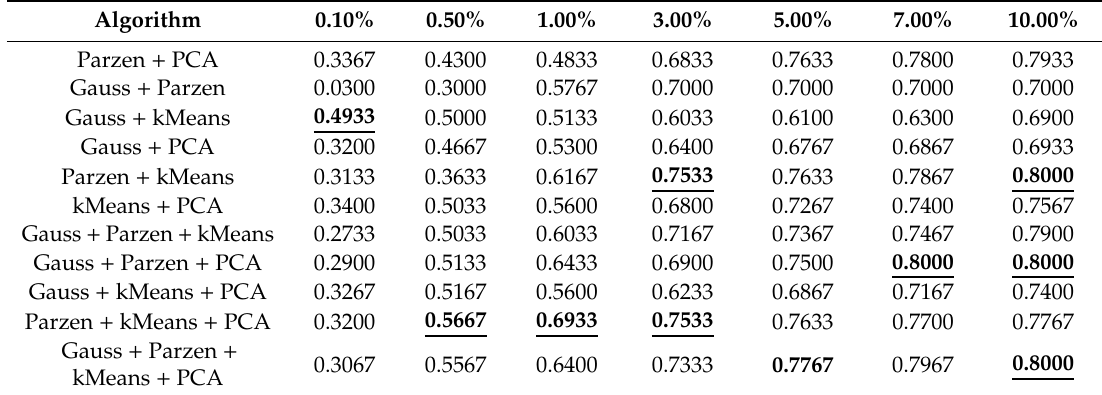
Table A4. True detection rate of each anomaly detection algorithm based on the daily activity summary dataset (Electrical Engineer). Best performance is shown in bold and underlined.